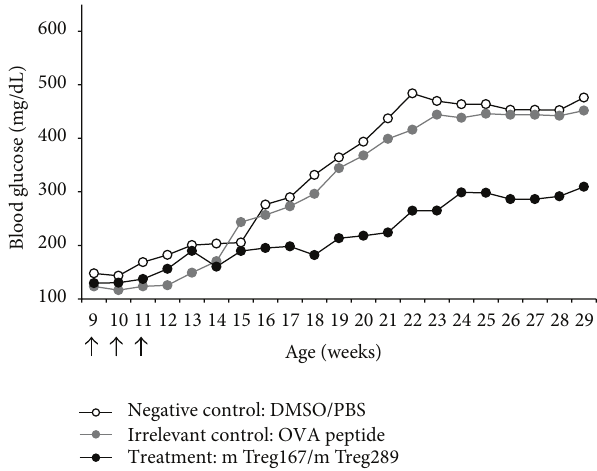
Figure 4: Study 1—prevention of T1D in NOD mice using Tregit- opes. Tregitopes in saline, given IP prior to onset of diabetes, had a moderately suppressive effect on development of diabetes in NOD mice. The incidence of diabetes for each arm is shown along the course of the study beginning at the first week that the mice received treatment. Arrows represent time points when Tregitope treatment was administered. Mice receiving vehicle alone (white circles) or irrelevant peptide (gray circles) had a higher incidence of diabetes at 29 weeks of age than mice receiving Tregitope treatment (black